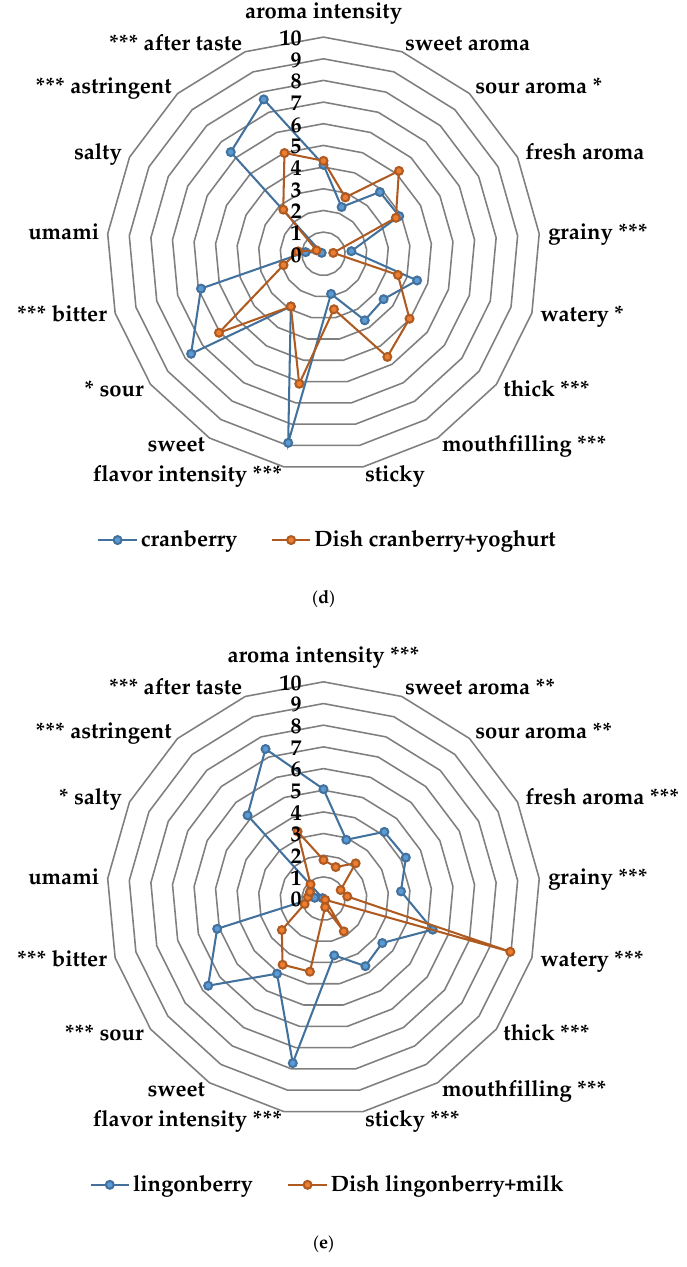
Figure 4. ( a ) Sensory profiles of the different fruit and berry pur é es in the taste portion schedule together with mango pur é e, a commercial product from Semper AB; ( b ) sensory profiles of the different vegetable pur é es in the taste portion schedule together with corn-potato pur é e, a commercial product from Semper AB; ( c ) sensory profile of the cauliflower spread of the exposure meal compared to the cauliflower pur é e in the taste portion schedule; ( d ) sensory profile of the cranberry yogurt in the exposure meal compared to the cranberry pur é e in the taste portion schedule; ( e ) sensory profile of the lingonberry milk of the exposure meal compared to the lingonberry pur é e in the taste portion schedule. Significant differences across the sensory attributes * p < 0.05, ** 0.01< p < 0.05, *** p <